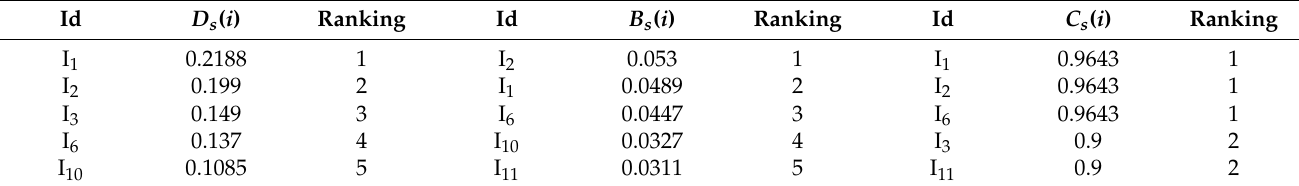
Table 3. Values and rankings of the top five factors of the three centrality attributes.